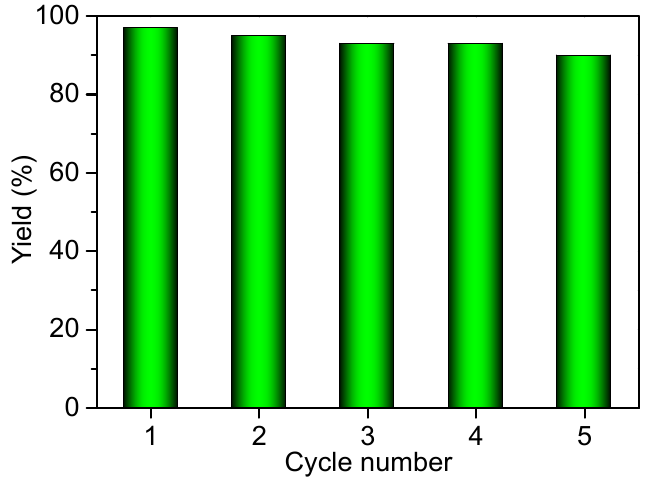
Figure 6. Catalytic activity of recycled BMIM4F-Py-COF for cycloaddition of CO 2 to epichlorohydrin.